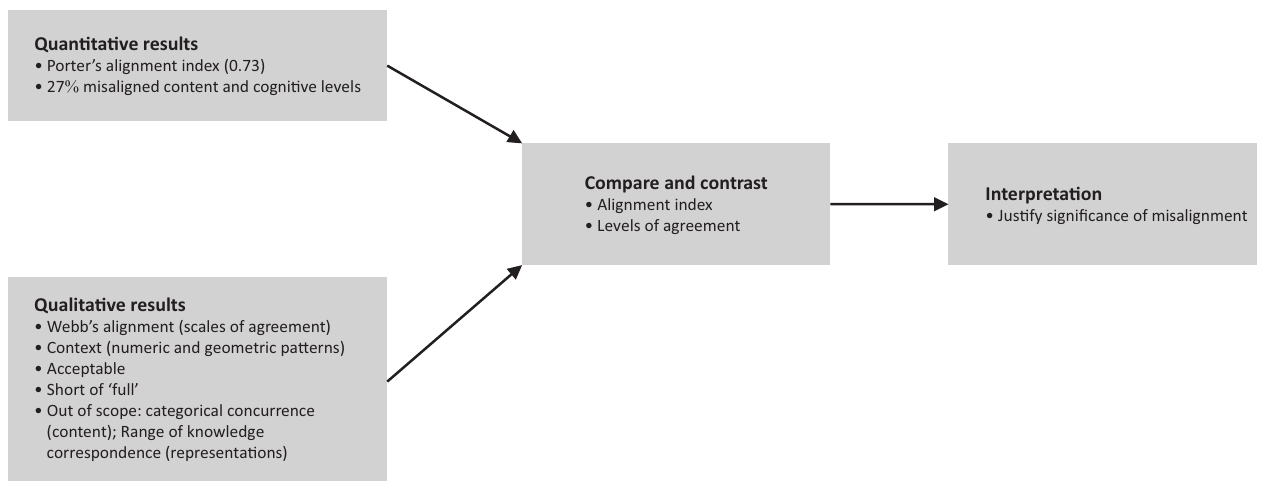
Quan(cid:27)ta(cid:27)ve results • Porter’s alignment index (0.73)